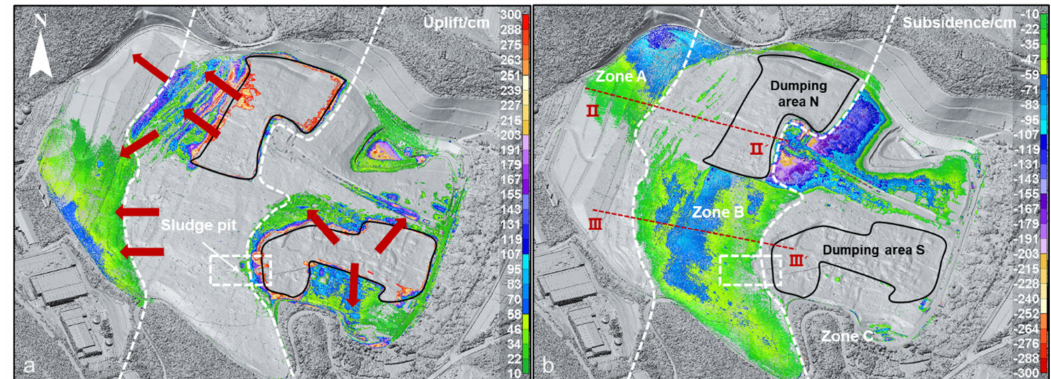
Figure 10. UAV-derived vertical displacements: ( a ) uplift; ( b ) subsidence. The white dashed lines show the boundaries of zone A, zone B, and zone C. The red arrows in ( a ) indicate the direction of landfill mobility. The red dashed lines in ( b ) represent the profile distribution used for cross-comparison between InSAR and